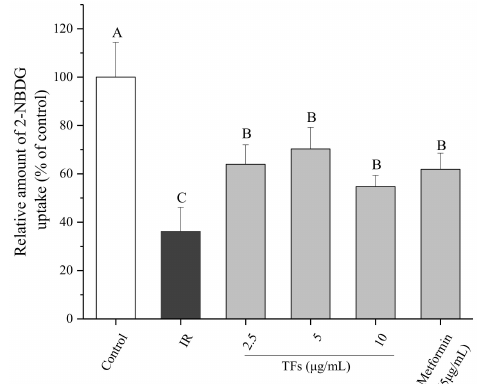
Figure 4. Effects of theaflavins (TFs) on 2-NBDG uptake of insulin-resistant HepG2 cells induced by PA. Metformin is used as a positive control. Data are represented as means ± SD from five replicates. Significant differences between different treatments are showed by different letters ( p <